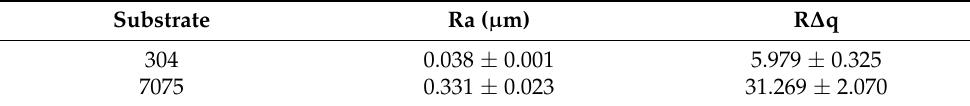
Figure 7. Surface morphology of the substrates pre-treated by mechanical grinding using 800 # SiC sandpaper: ( a ) 2D photo and tested lines of 304 substrate, ( b ) 3D surface topography of 304 substrate, ( c ) Surface profiles of line 1~3, ( d ) 2D photo and tested lines of 7075 substrate, ( e ) 3D surface topography of 7075 substrate, ( f ) Surface profiles of line 4~6. Table 3. Surface roughness of the substrate prior to coating